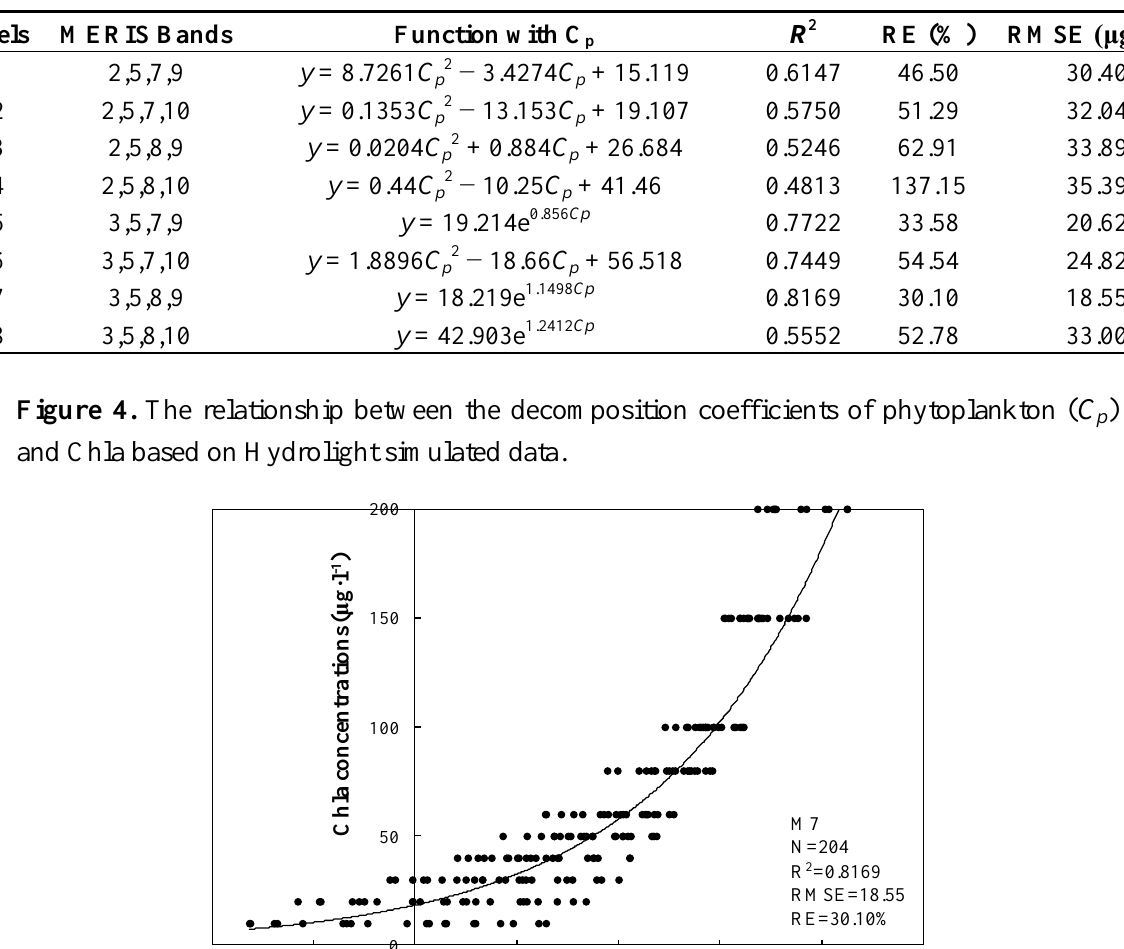
Table 2. Accuracy evaluation of different spectral decomposition models using MERIS band-combinations of the simulated model-construction dataset.